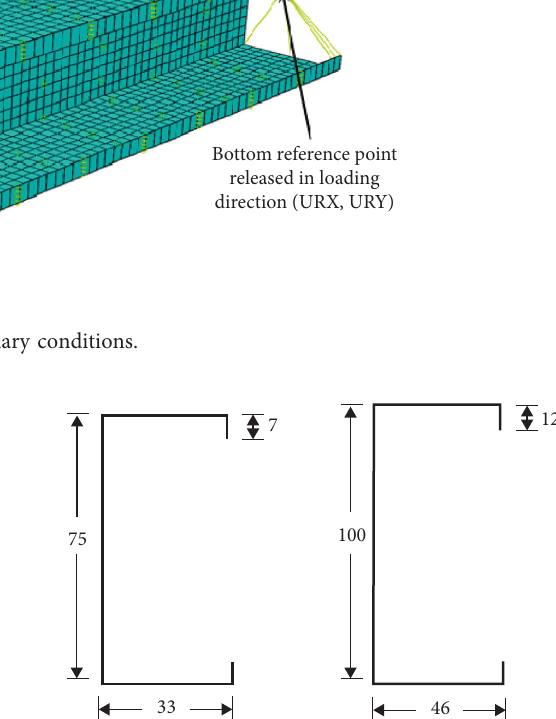
Figure 5: Typical cross section of C7510, C7512, and C10010